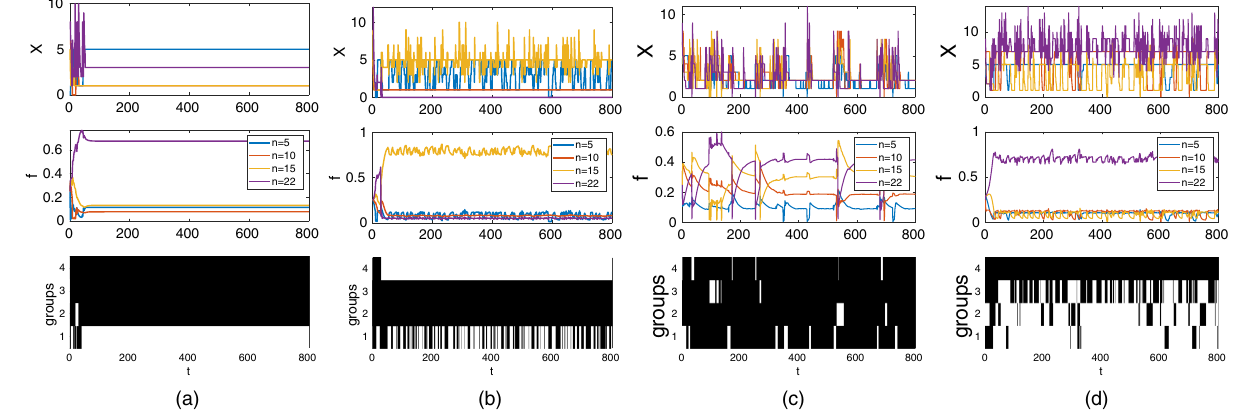
Figure 7. The dynamics of three groups of 5, 10, 15 individuals respectively and the focal group of n individuals are illustrated. Examples of two main types of dynamics for high values of n are shown: ( a ) the focal group cooperates and has the highest power among all groups; ( b ) there is no contributing individuals in the focal group. Baseline parameters: n = 22 , B 1 = 100 , B 2 = 1500 , α = 1 , ε = 0.3 , c = 1 , π 0 = 1 , X 0 = 5 , Z 0 = 300 , µ 1 = µ 2 = 0.25 . Examples of non-equilibrium dynamics for (c) ε = 0 ; and (d) ε = 0.3 . Baseline parameters: n = 20 , B 1 = 300 , α = 1 , b 2 = 40 , c = 1 , π 0 = 1 , X 0 = 5 , Z 0 = 300 , µ 1 = µ 2 = 0.25